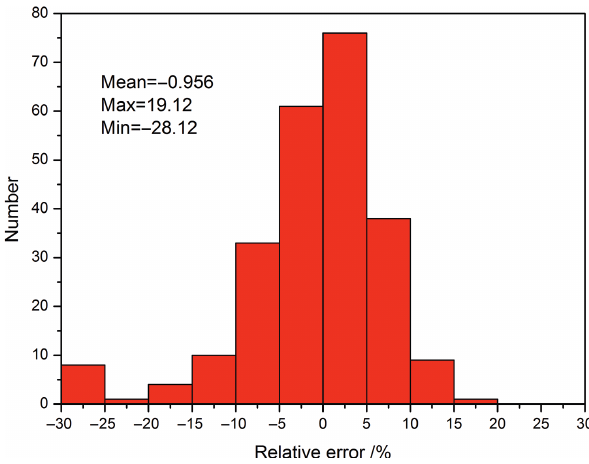
Figure 18: Statistical analysis of the relative error for SCA constitu- tive